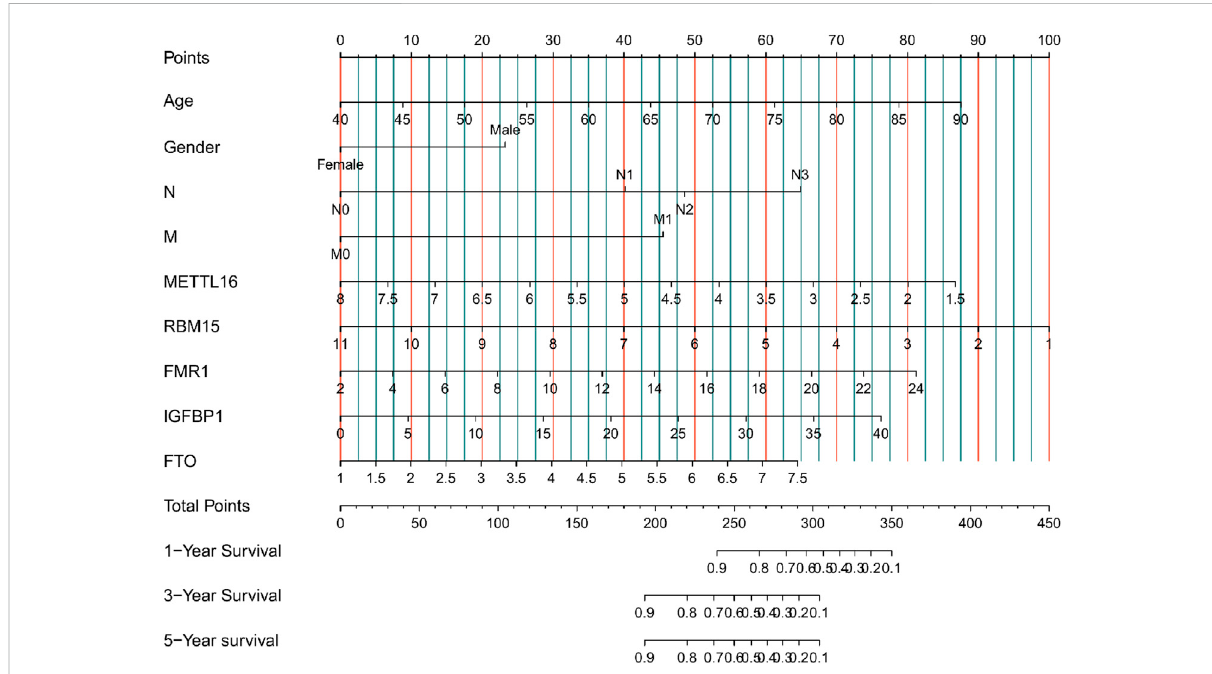
FIGURE 3 Nomogram for predicting 1-, 3-, and 5-year overall survival (OS) for GC patients in the training